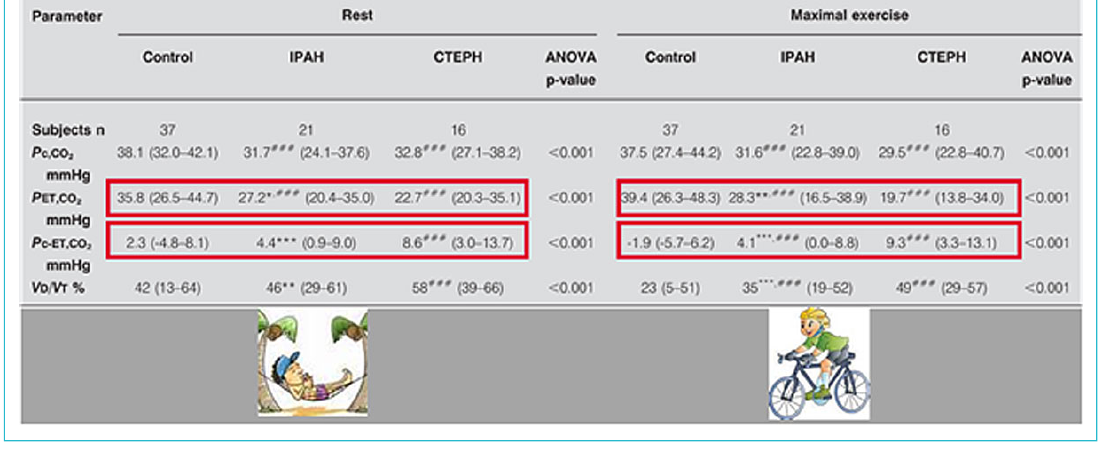
Figure 6: Heterogeneous pulmonary perfusion is the hallmark of CTEPH, with progressive CTEPH, nonoccluded arteries tend to narrow (re- modelling), this reduced extend of blood flow heterogeneity. Reproduced with permission of the European Respiratory society. Eur Respir J. 2012;39(1):119-124 [53]. © ERS 2012.